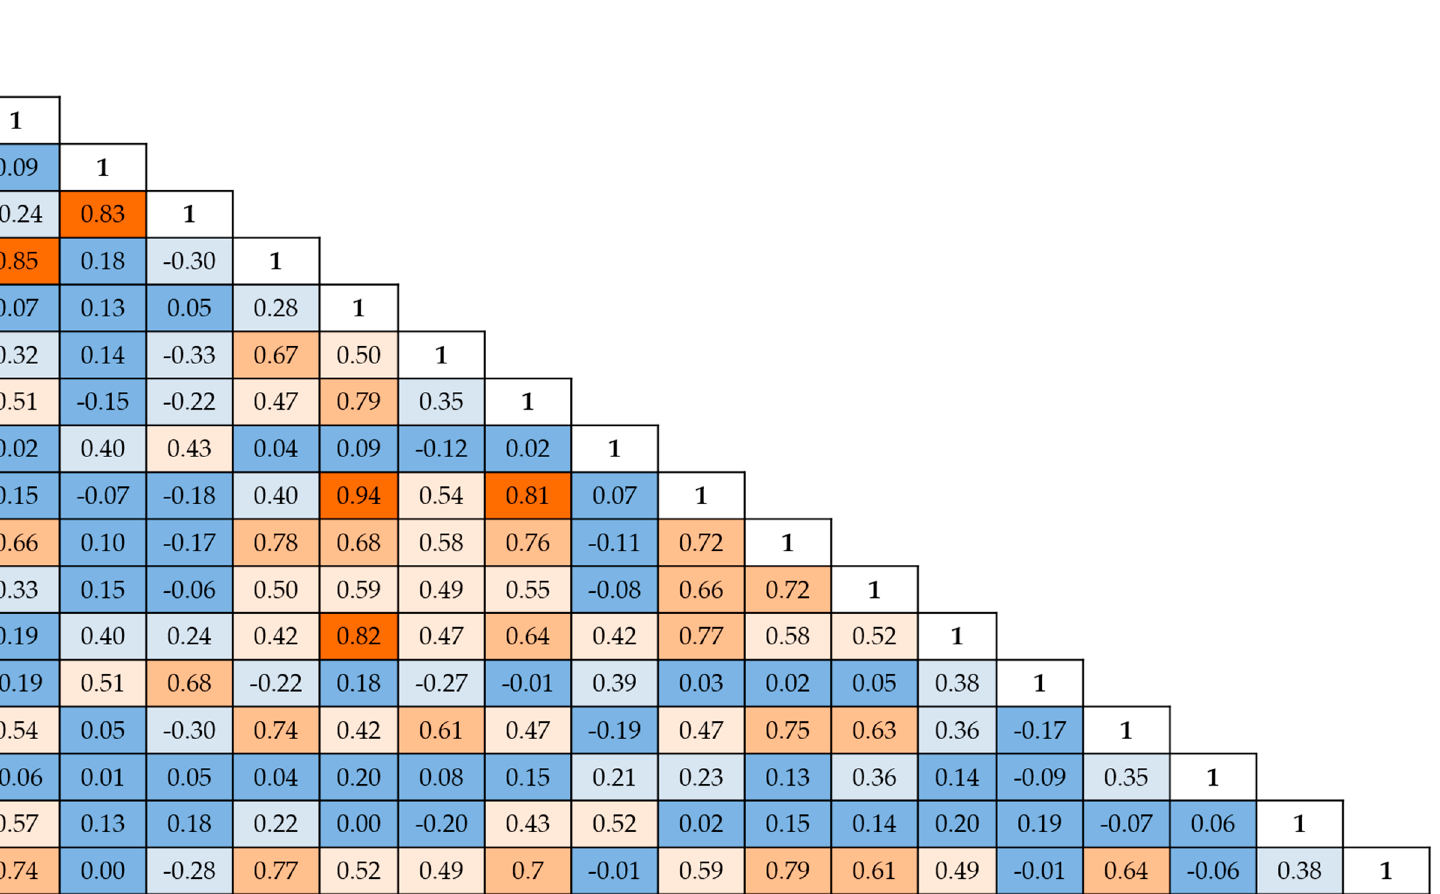
Table 2. Correlation matrix obtained by the PCA4 (principal component analysis) analysis (24 samples) considering the concentration of Cl − , NO 3 − , SO 42 − , Na + and NH 4+ and the concentration of each single metal. The color code depicts in blue values between 0 and 0.2, in light blue values between 0.2 and 0.4, in light orange values between 0.4 and 0.6, in orange values between 0.6 and 0.8 and in dark orange values between 0.8 and 1.